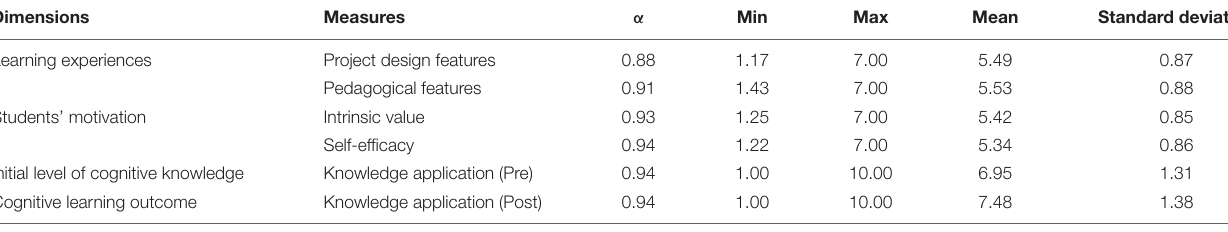
TABLE 1 | Descriptive statistics and reliabilities.